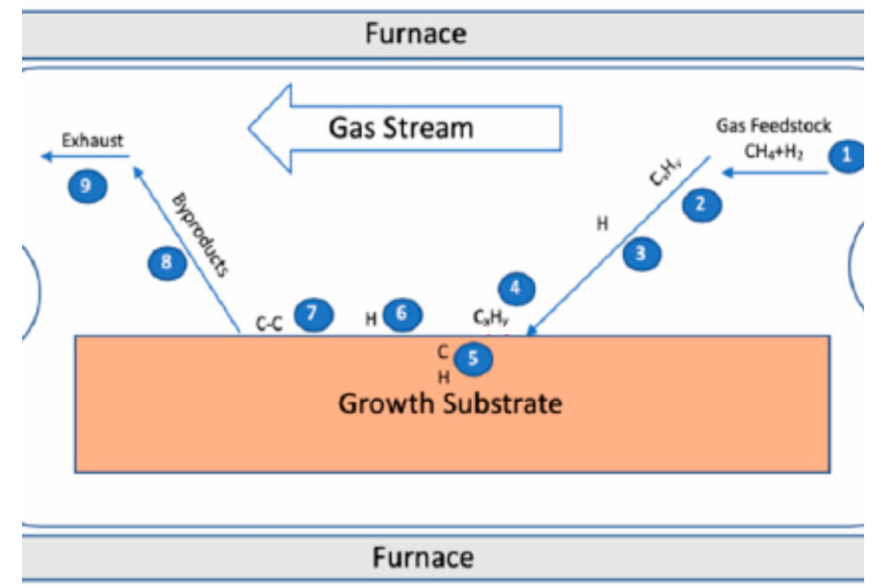
Figure 3. Thermal CVD growth of graphene